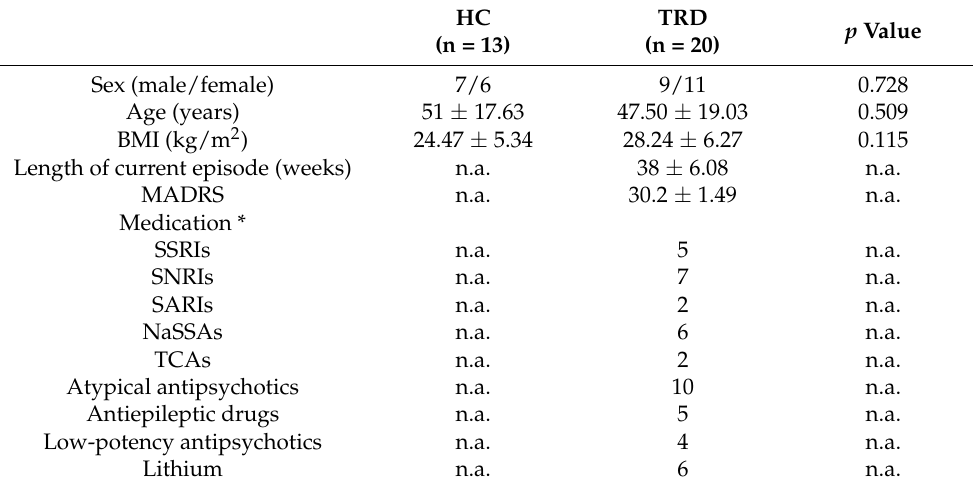
Table 1. Basic characteristics of study